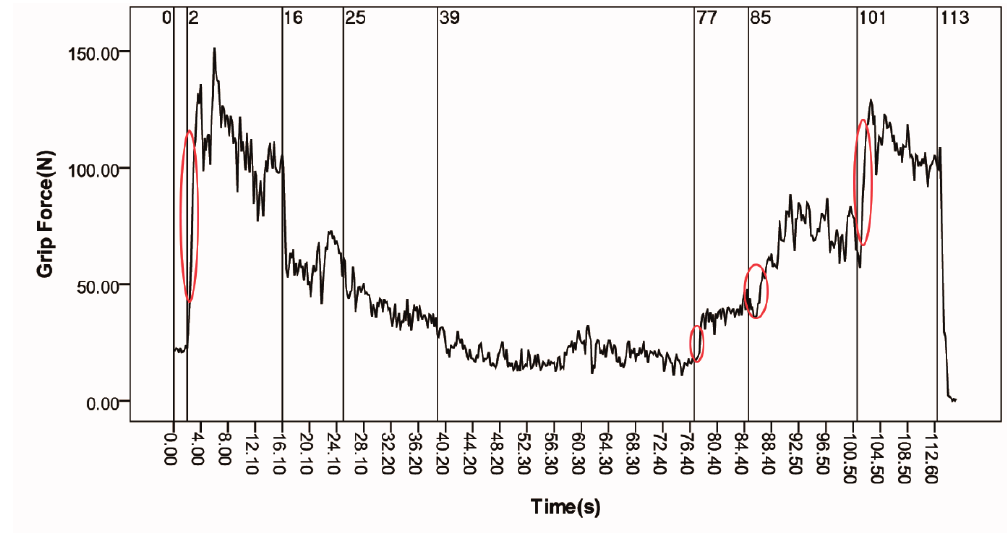
Figure 12. The result of hand grip force for the whole trip.